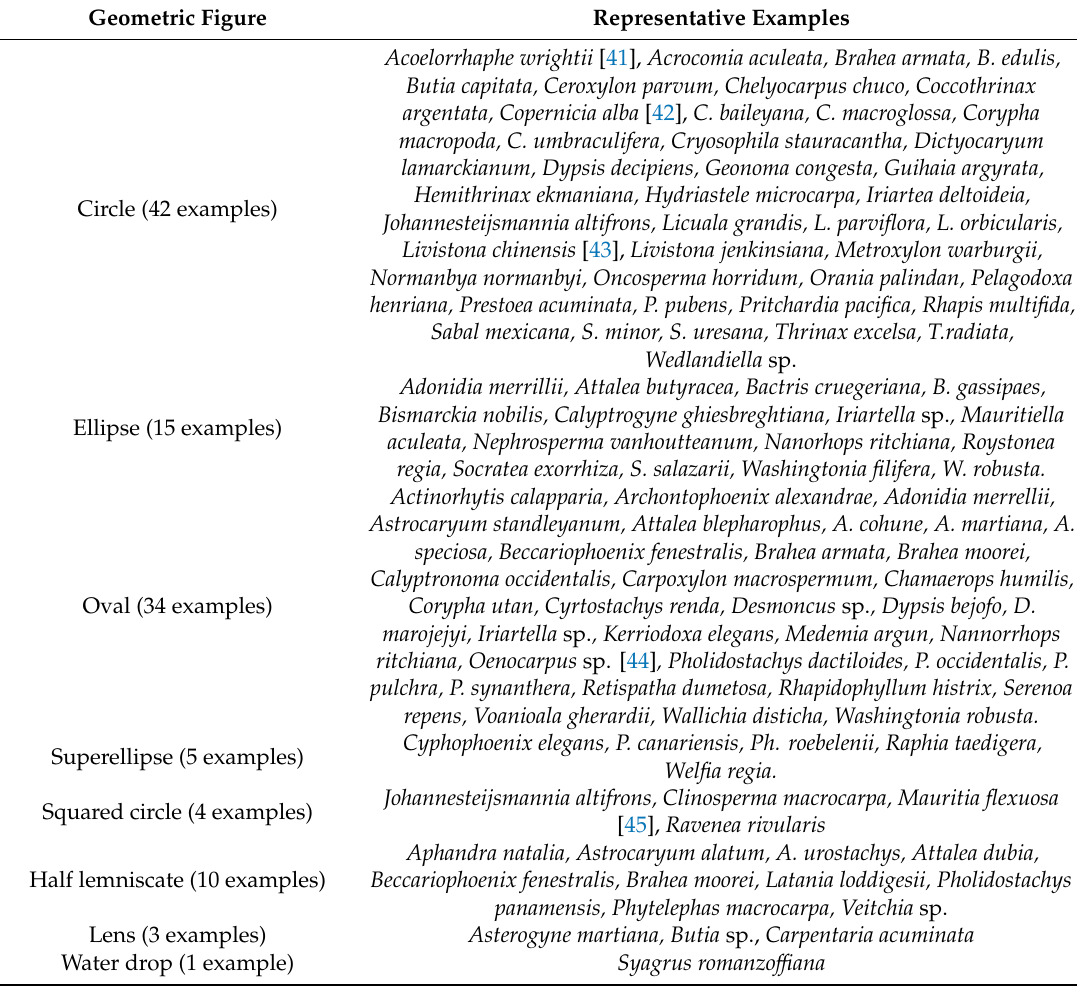
Table 3. Geometric models with some representative examples of seeds for each morphological type. Geometric Figure Representative